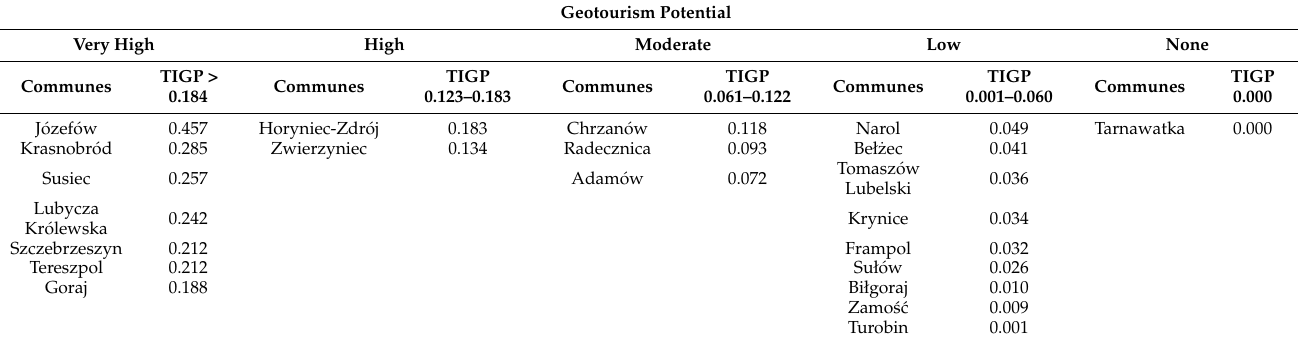
Table 6. Diversity of the geotourism potential of communes located within the Roztocze TBR shown by the Total Indicator of Geotourism Potential TIGP. Geotourism